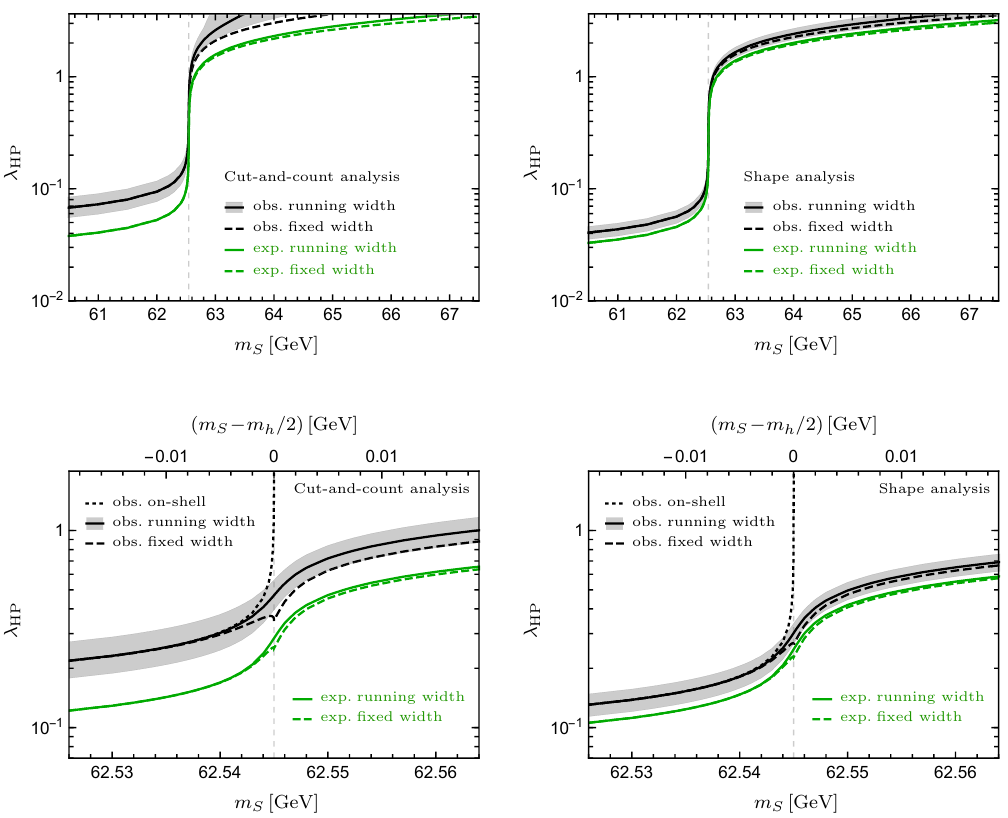
Figure 2 . Upper limits at the 95 % CL on the Higgs-portal coupling (cid:21) HP as a function of the DM mass m S . We present results for the cut-and-count analysis (left) and the shape analysis (right) of ref. [39]. We show a wide range for the dark-mater mass (top) as well as a zoom into the most interesting threshold region (bottom). In all plots, we show expected as well es observed limits employing the (cid:12)xed- and the running-width description for the Higgs propagator. The grey band around the running-width observed limit indicates the 17 % uncertainty on the Higgs production cross-section stated in ref. [39]. In the threshold-region plots (bottom), we also indicate the limits due to the decay of an on-shell Higgs boson into DM